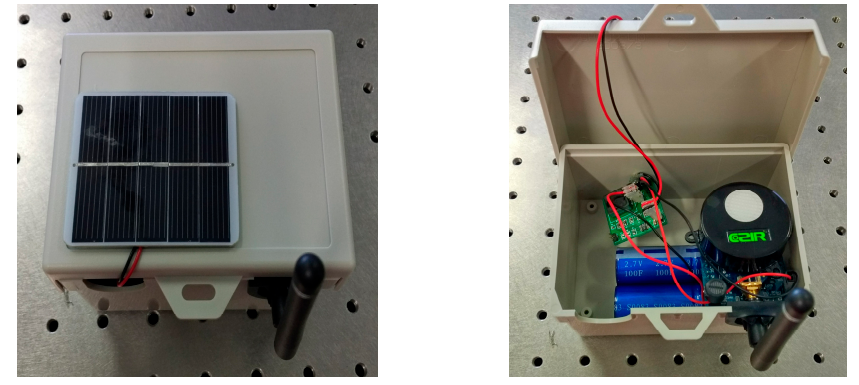
Figure 2. Sensor nodes with solar energy harvesting.